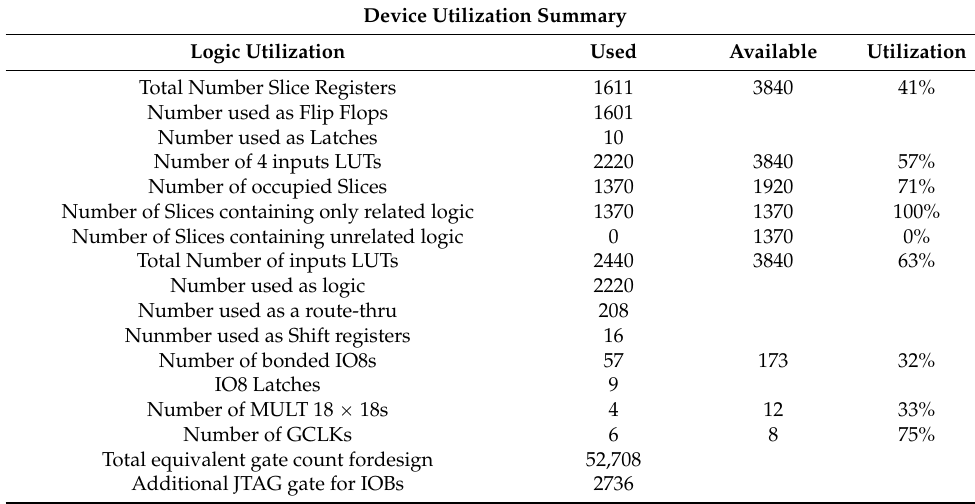
Table 1. Total used logic cells for the proposed device implemented on a Spartan 3-XCS200.